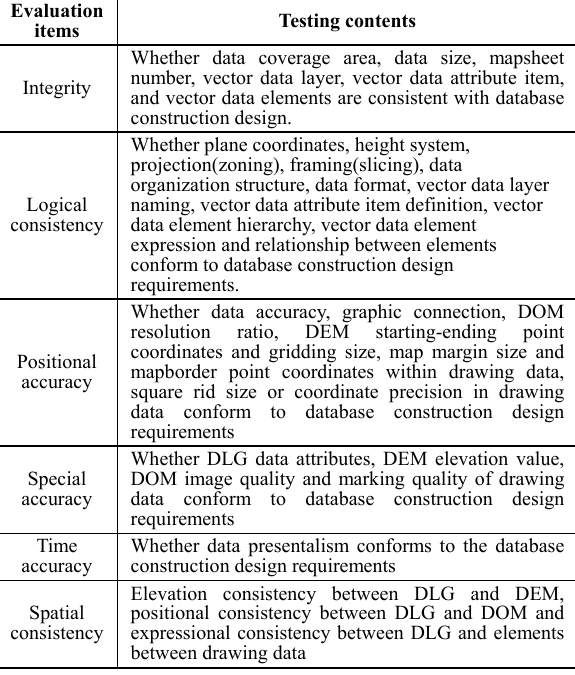
Table 2. Conformance Evaluation of Dataset Quality